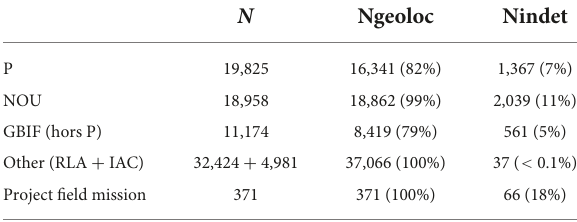
TABLE 1 Summary of the original data aggregated per dataset with N, occurrence number; Ngeoloc, number of geolocated data; Nindet, number of occurrence not identified at species or lower